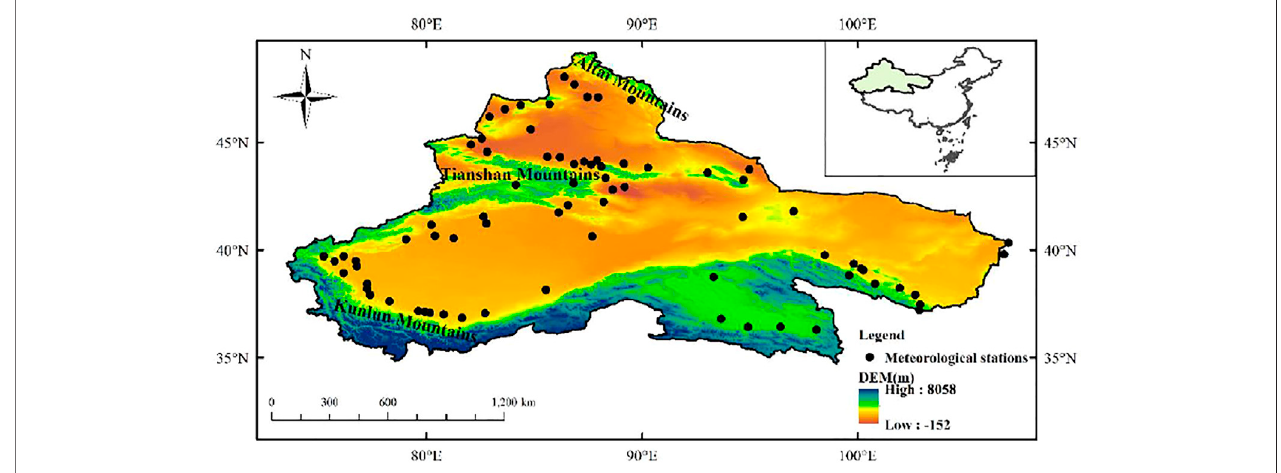
FIGURE 1 | Location of the study area and the distribution of the meteorological stations.